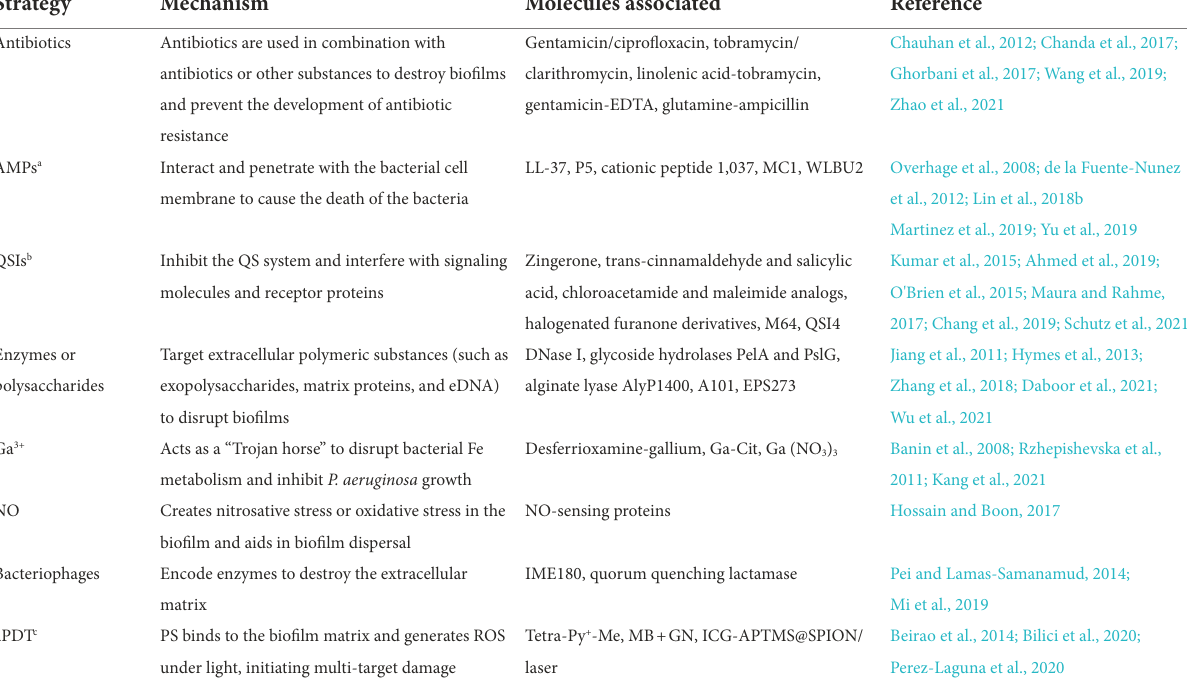
TABLE 1 Different strategies to treat Pseudomonas aeruginosa infectious biofilms.